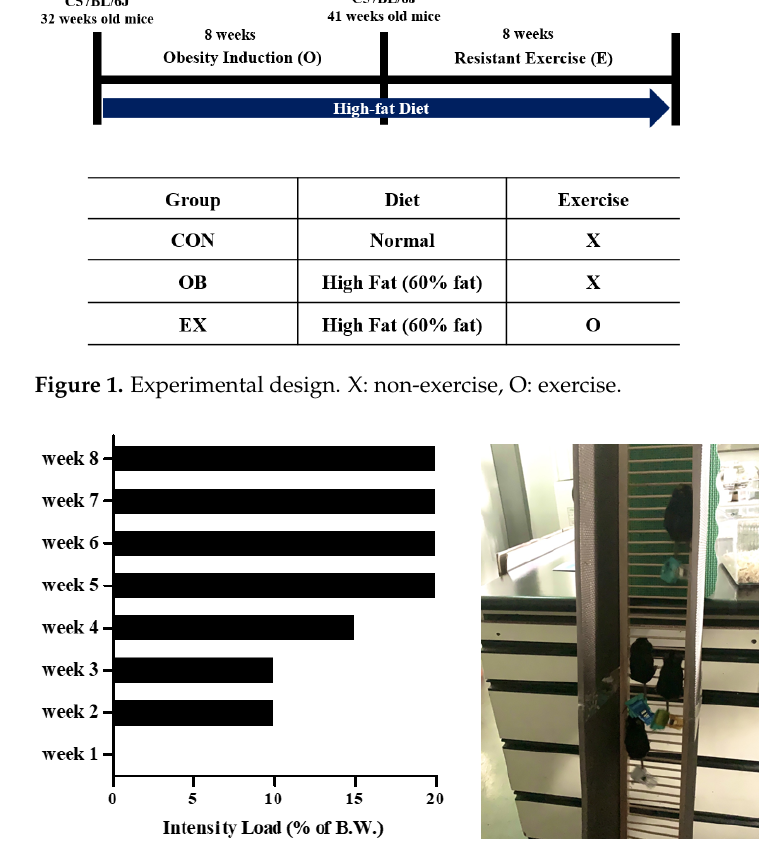
Figure 2. The incremental intensity load applied to the resistant exercise.